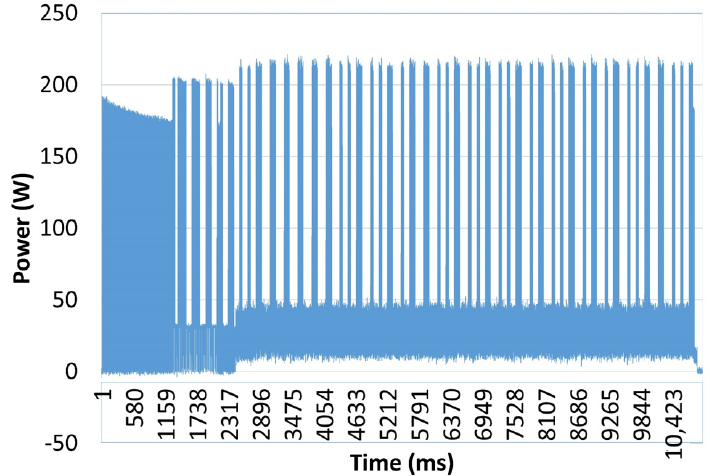
Figure 2. Printing sample.